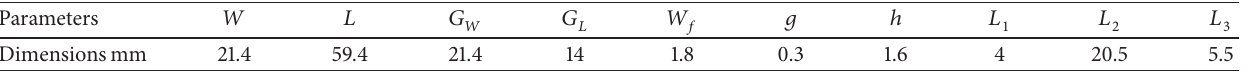
Table 1: Antenna